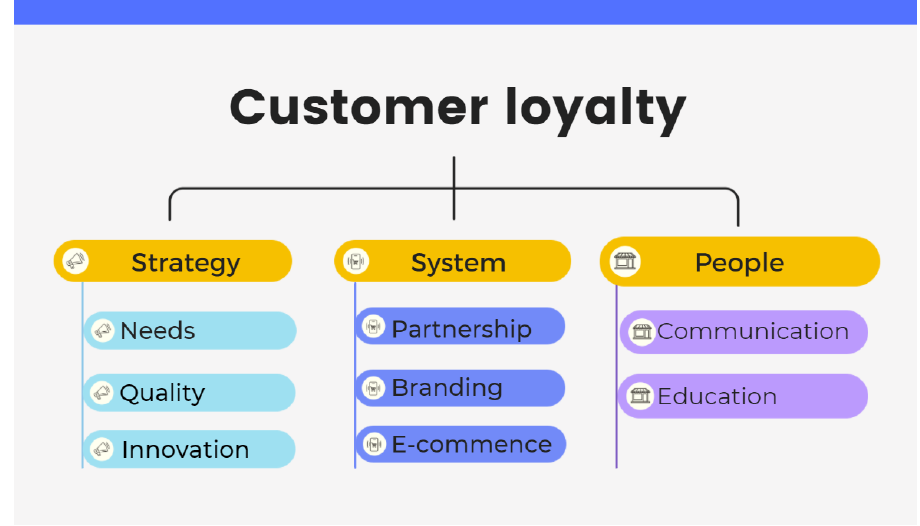
Figure 13. The framework of market-led innovation for organic food (organized by the authors based on the framework of Doyle and Bridgewater, 2012 [18]).